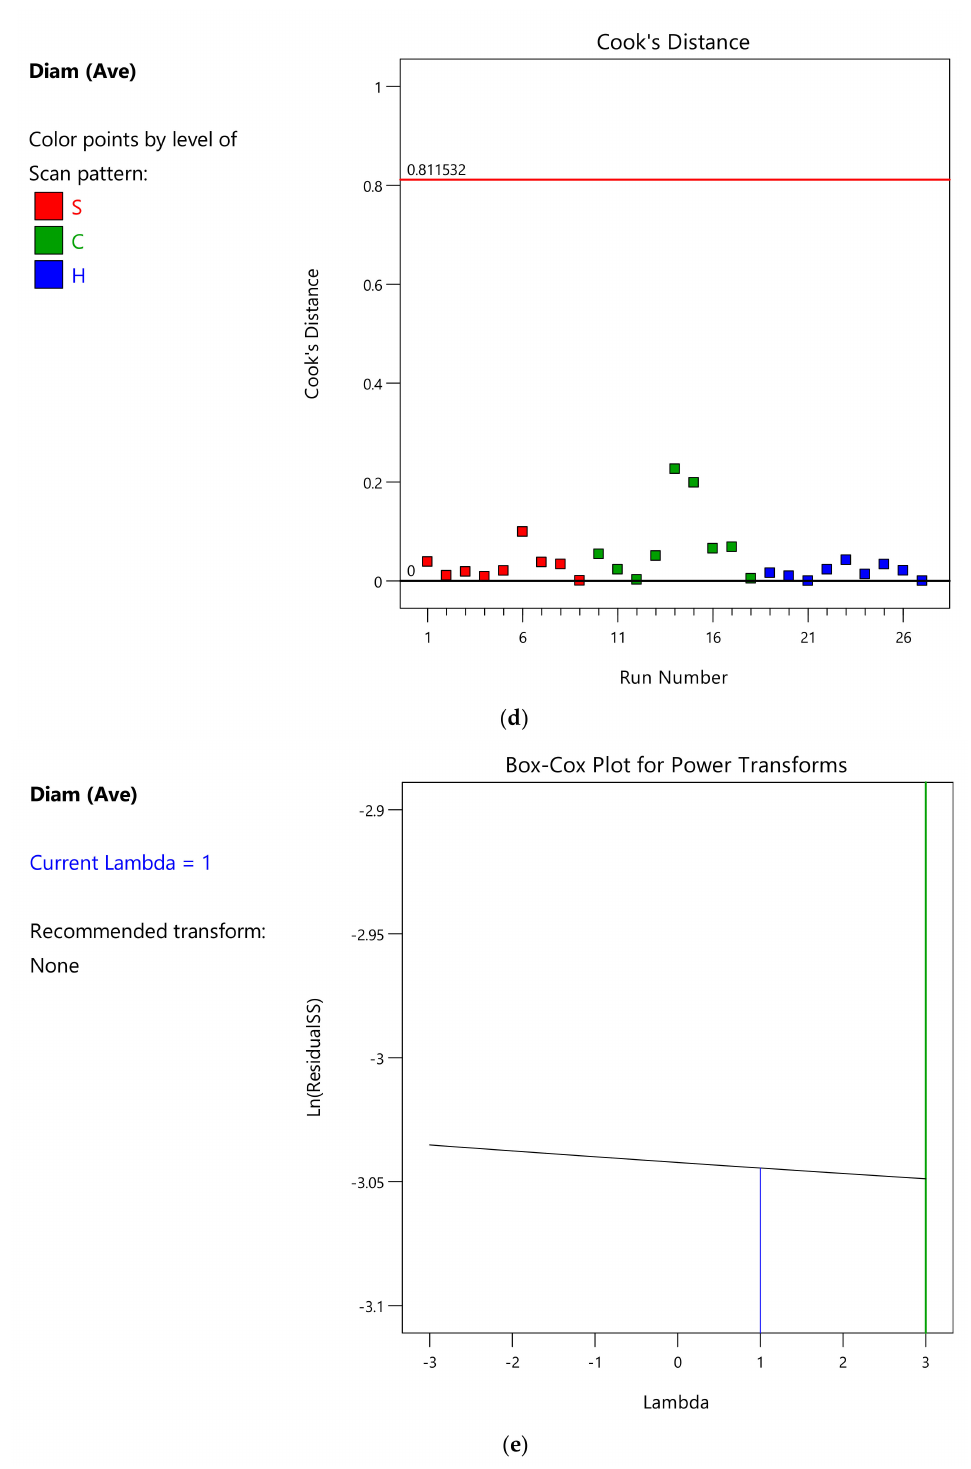
Figure A1. Statistical quality assertion: ( a ) Half-Normal plot vs. Externally studentized residuals for random error check, ( b ) Residuals vs. predicted value for independent residuals, ( c ) Residual vs. run for the absence of variation from printing location, ( d ) Cook’s distance plot for identification of outliers and ( e ) Box-Cox plot to identify any need of a transformation of the